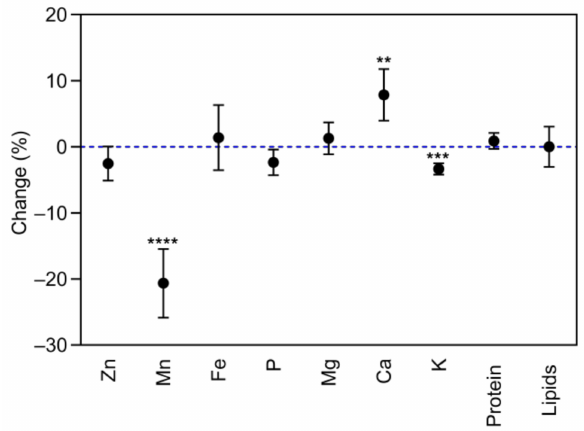
Figure 7. Mean response change (%) of the seed mineral, protein, and lipid concentrations of 17 soybean varieties grown under aCO 2 (400 ppm) and eCO 2 (800 ppm). ** p < 0.01; *** p < 0.001; **** p < 0.0001 significance